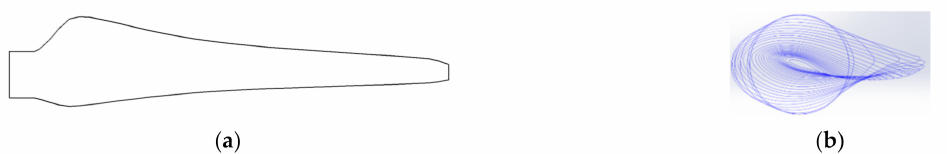
Figure 3. Photo of the sea trial in Zhoushan: ( a ) 120 kW tidal current turbine; ( b ) seawater with sediment.